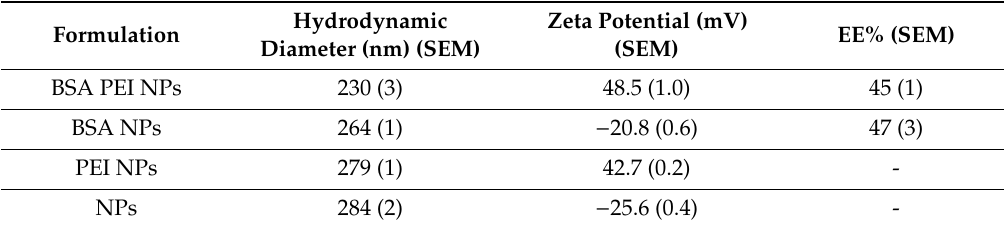
Table 1. Hydrodynamic diameter, Zeta potential and Encapsulation E ffi ciency (EE%) of NPs formulated in this work. SEM = Standard Error of the Mean, n =